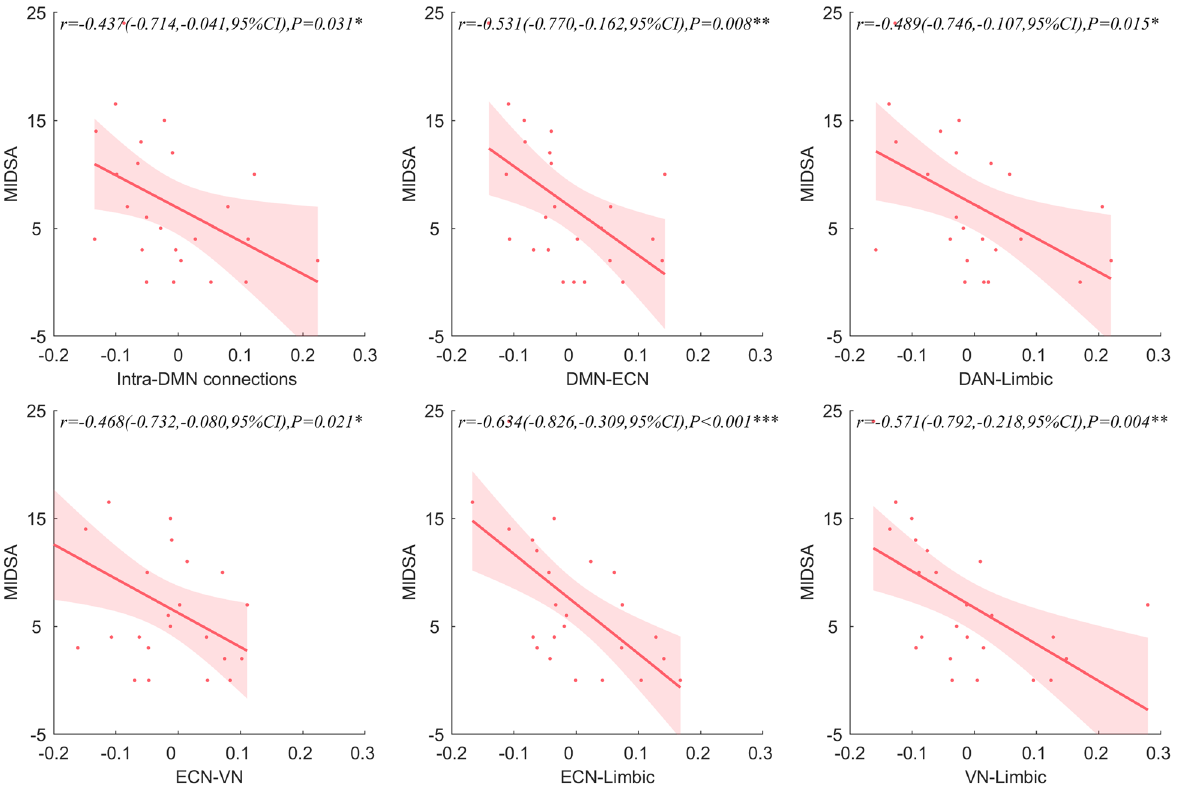
Fig.6 The correlation between Intra- and Inter-network FC and MIDAS of patient group. A . The correlation between MIDAS and intra-DMN connection. B . The correlation between MIDAS and the FC of DMN and ECN. C . The correlation between MIDAS and the FC of DAN and limbic network. D . The correlation between MIDAS and the FC of ECN and VN. E . The correlation between MIDAS and the FC of ECN and limbic network. F . The correlation between MIDAS and the FC of VN and limbic network. The correlation was analyzed by the residuals of intra-network connection and inter-network connection time series and MIDAS with age, sex and FD as covariates. DMN, default mode network; DAN, dorsal attention network; VN, visual network; ECN, executive control network, CI, confidence intervals; *** P < 0.001, ** P < 0.01, * P <